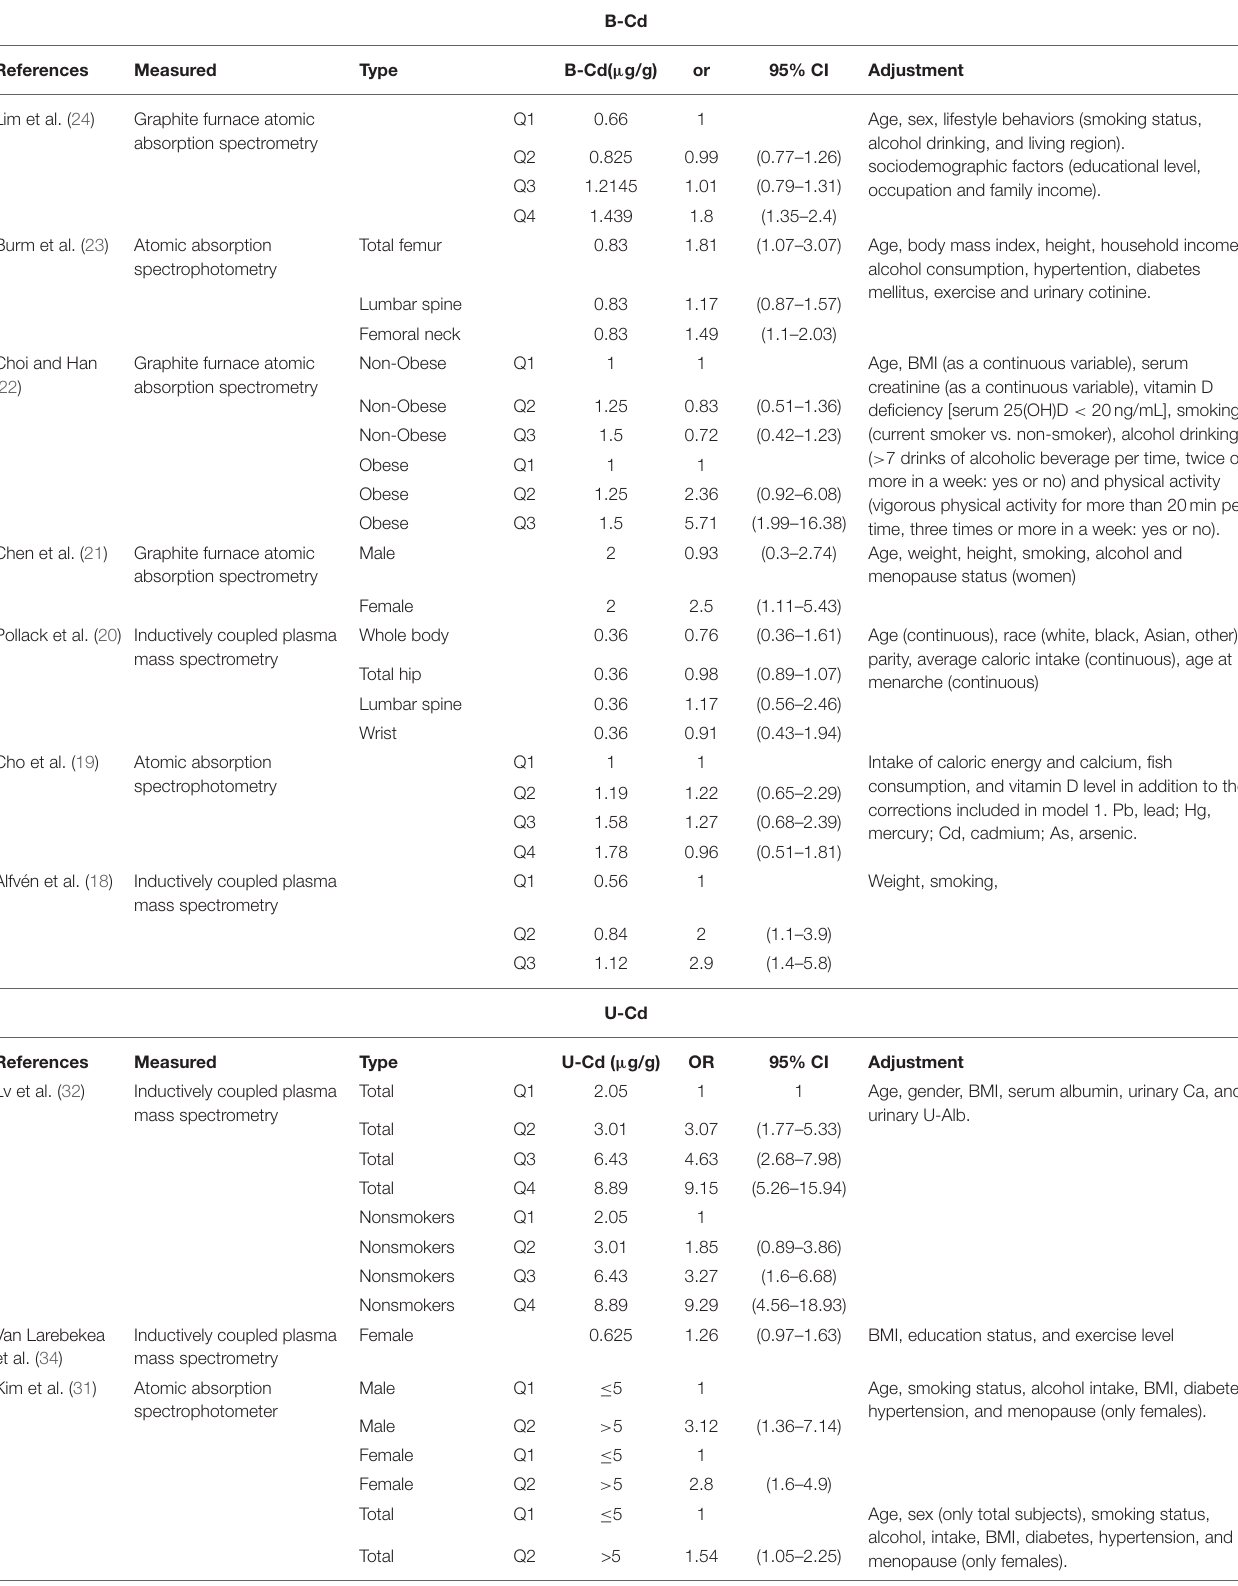
TABLE 2 | Summary characteristics of